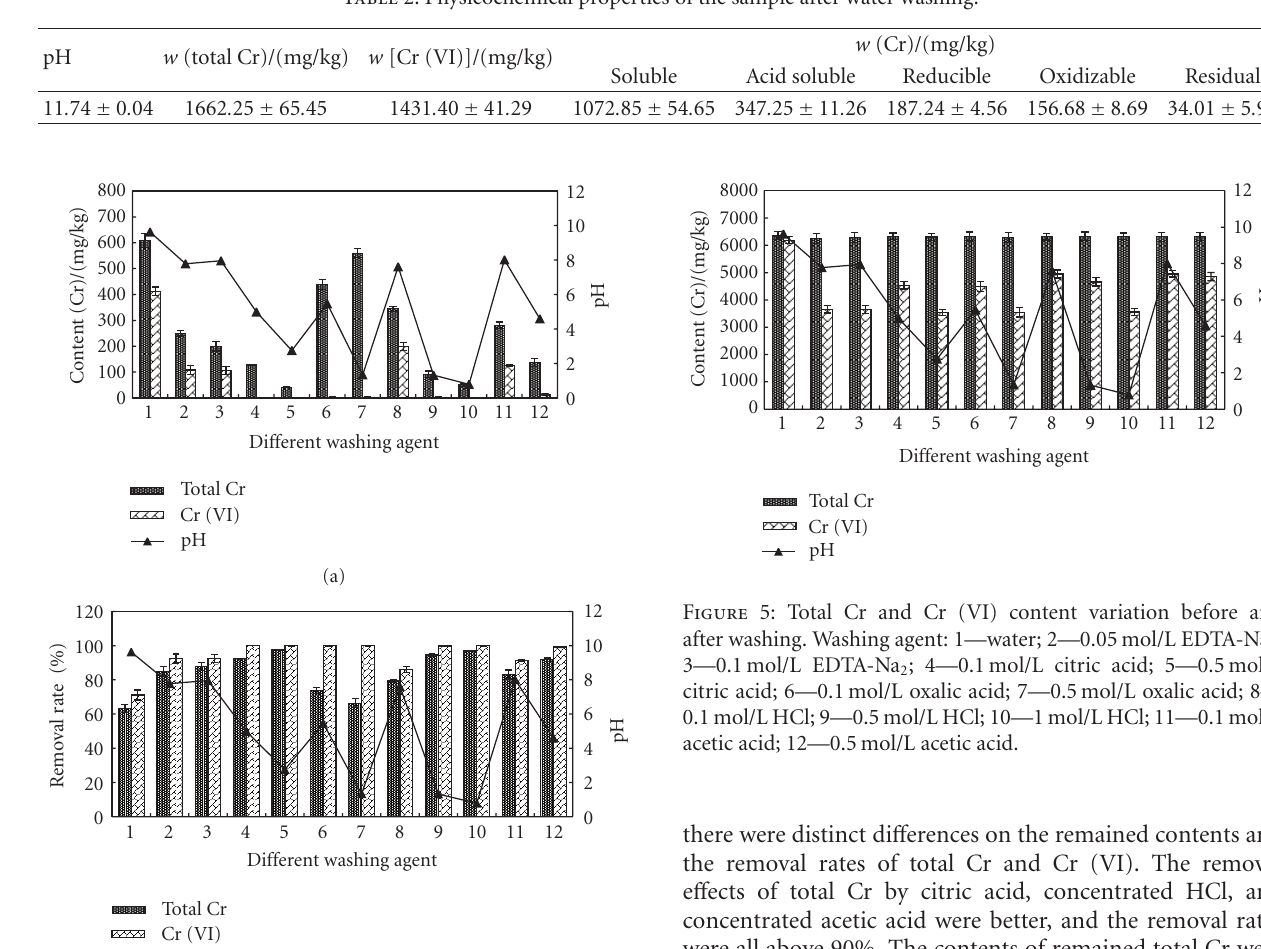
Table 2: Physicochemical properties of the sample after water washing.